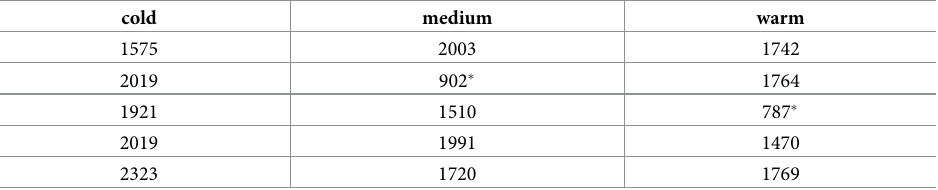
Table 1. Sums of discharged conidia. � indicate fungi that terminated discharge of conidia during the